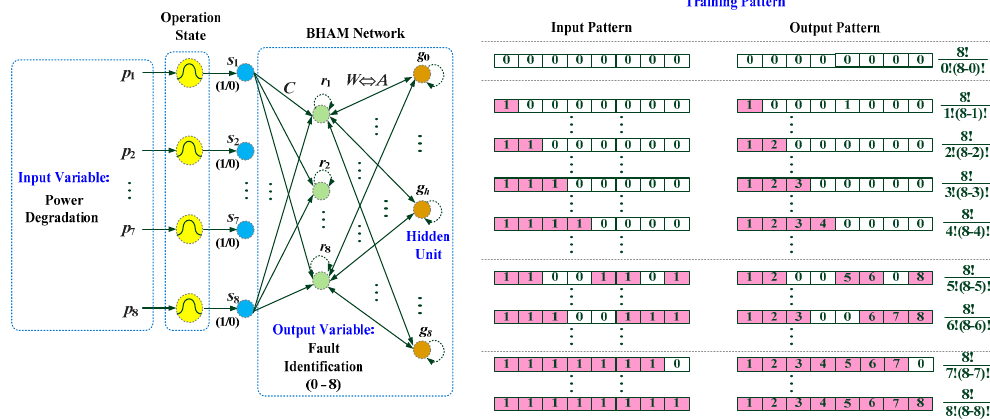
Figure 4. The configuration of BHAM network and input-output paired training patterns.